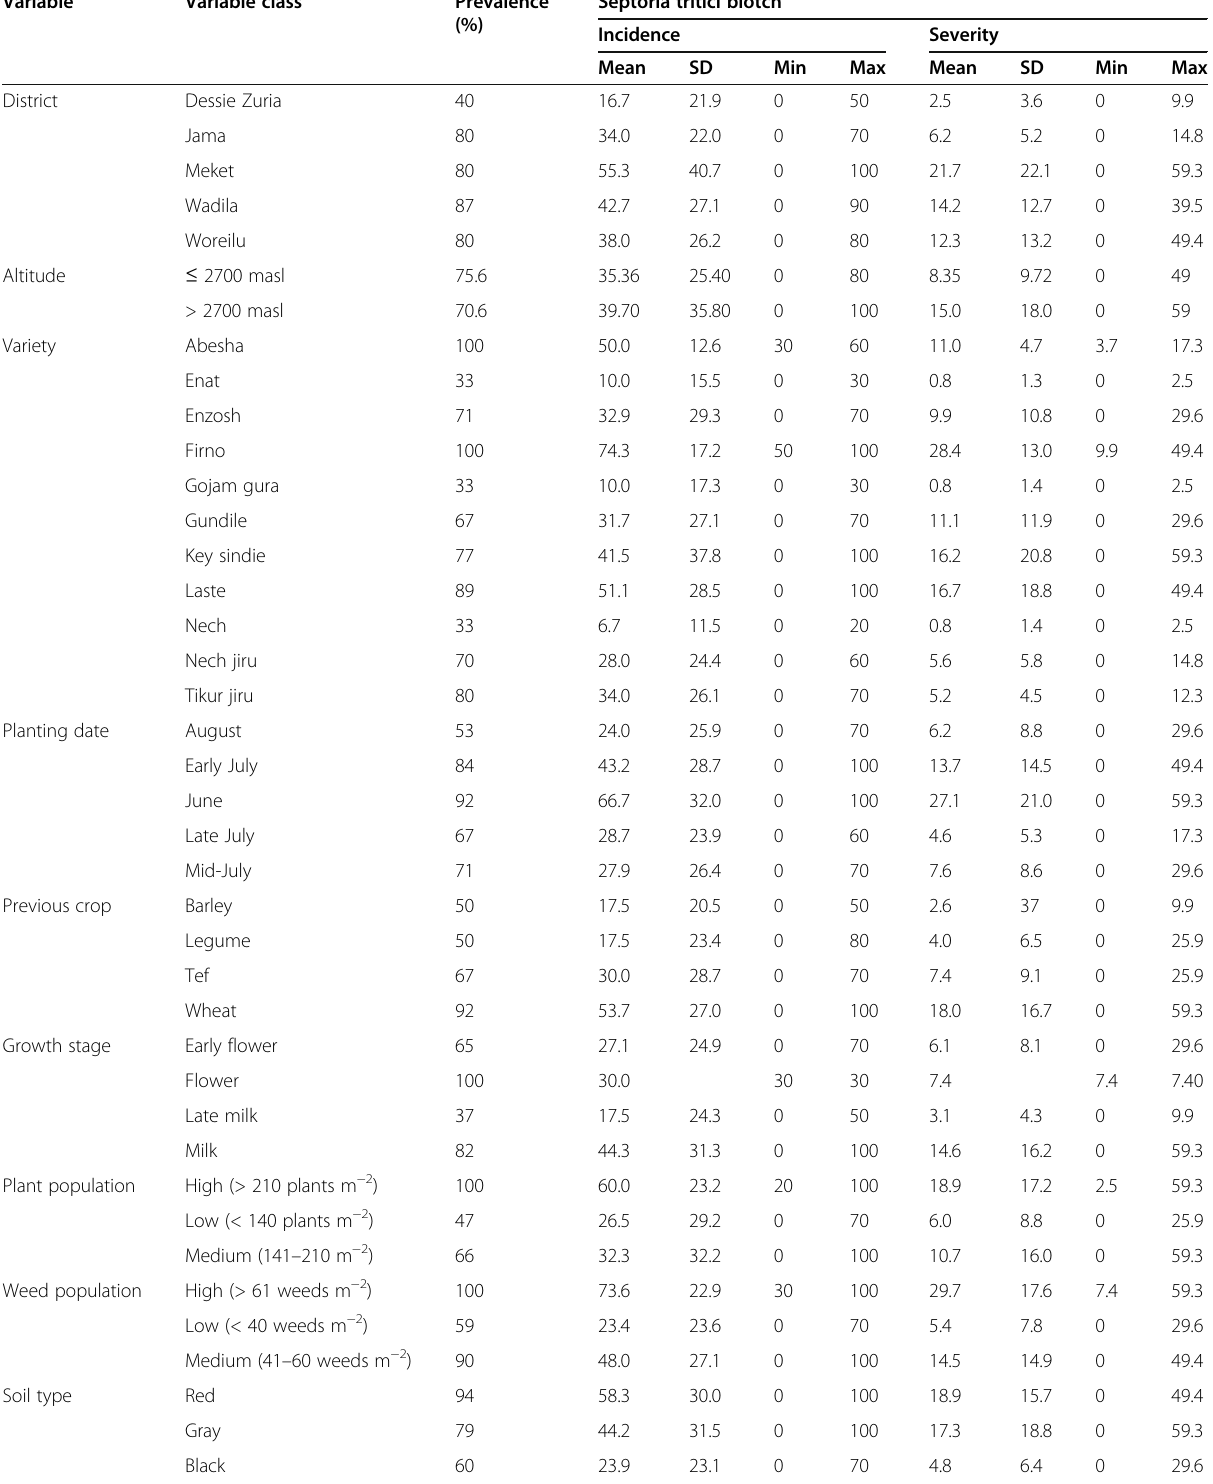
Table 2 Prevalence, mean incidence, and severity of septoria tritici blotch on durum wheat under different independent variables